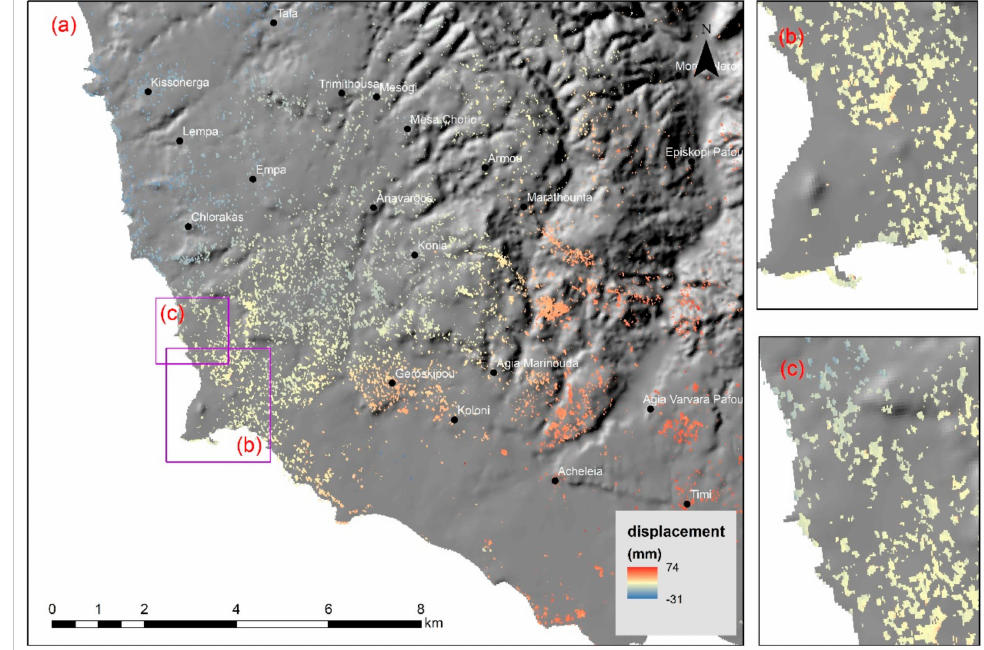
Figure 4. Final displacement map at ( a ) western Cyprus; ( b ) “Nea Paphos”; and ( c ) “Tombs of the